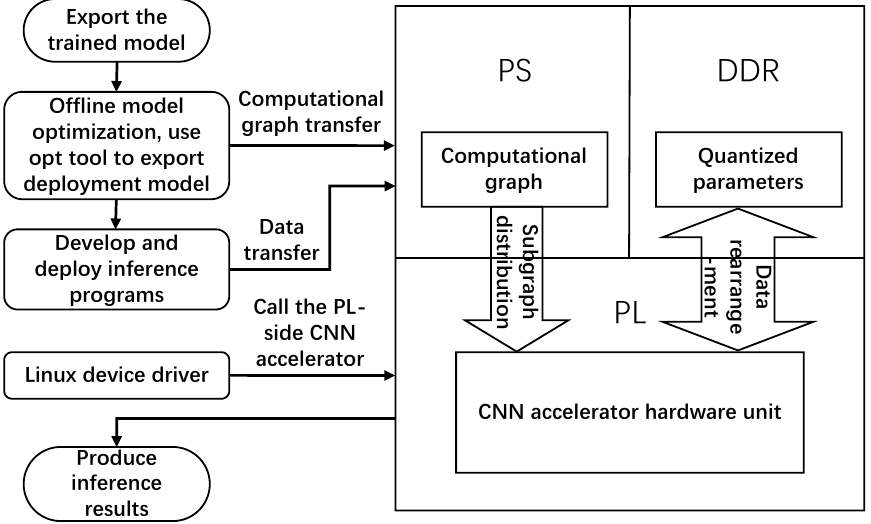
Figure 8. Partial inference framework for deploying the network model on the hardware.